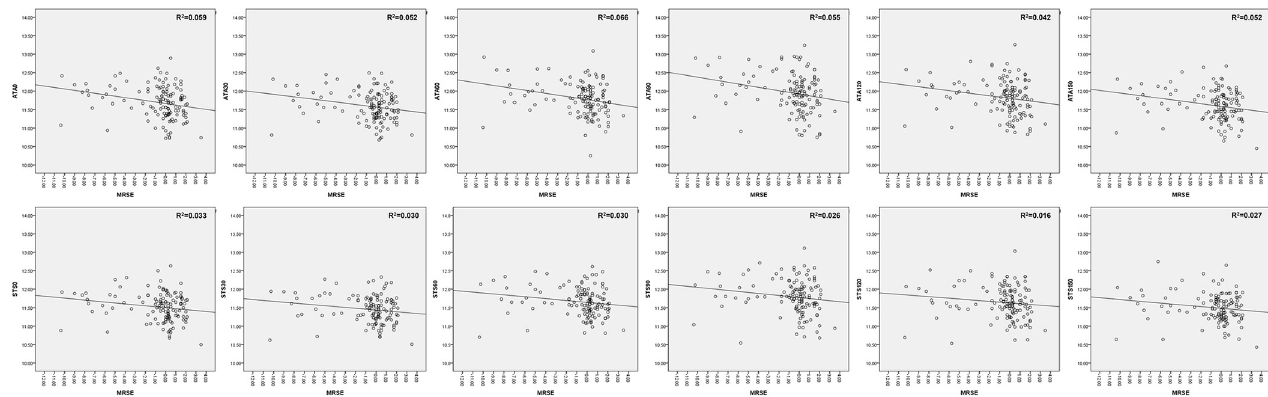
Fig 3. Scatter plots showing the relationship between angle to angle (ATA) and spur to spur (STS) versus manifest refractive spherical error (MRSE) in study population (126 eyes).